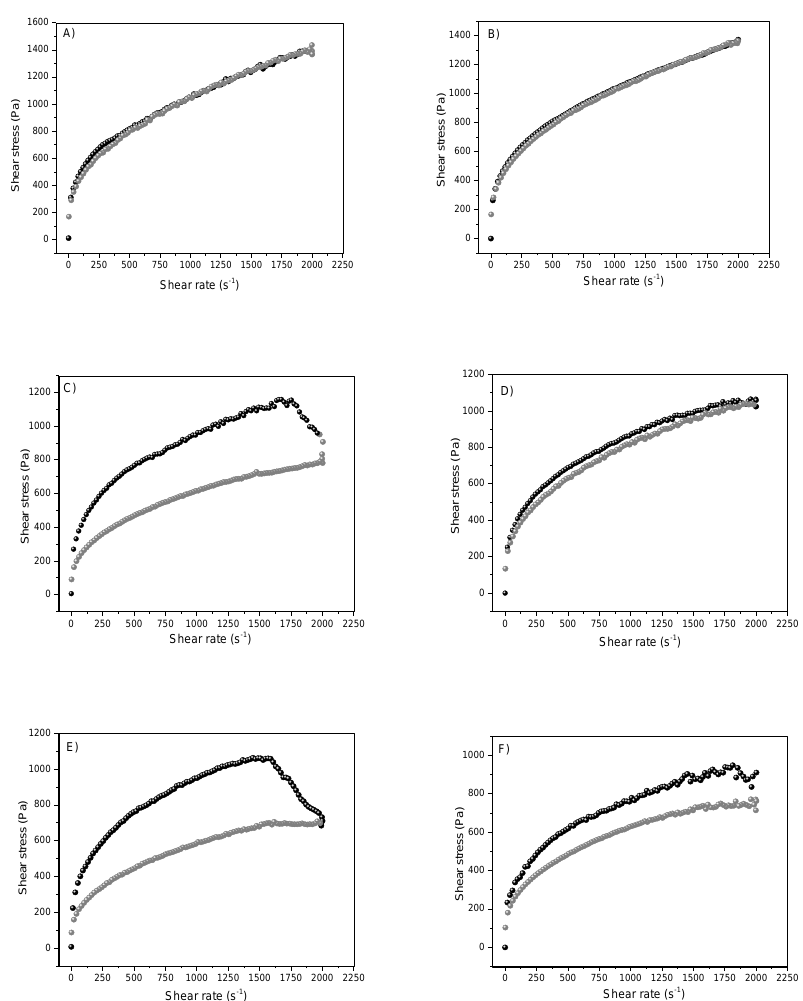
Figure 3. Flow curves of emulsion systems: ( A ) FC at 25.0 °C; ( B ) FC at 37.0 °C; ( C ) ECO 15 at 25.0 °C; ( D ) ECO 15 at 37.0 °C; ( E ) ECO 20 at 25.0 °C; ( F ) ECO 20 at 37.0 °C. The symbols and refer to upward and downward, respectively. Standard deviations are omitted for clarity; however, the relative standard deviation of the replicate analysis was less than 10% in all cases.